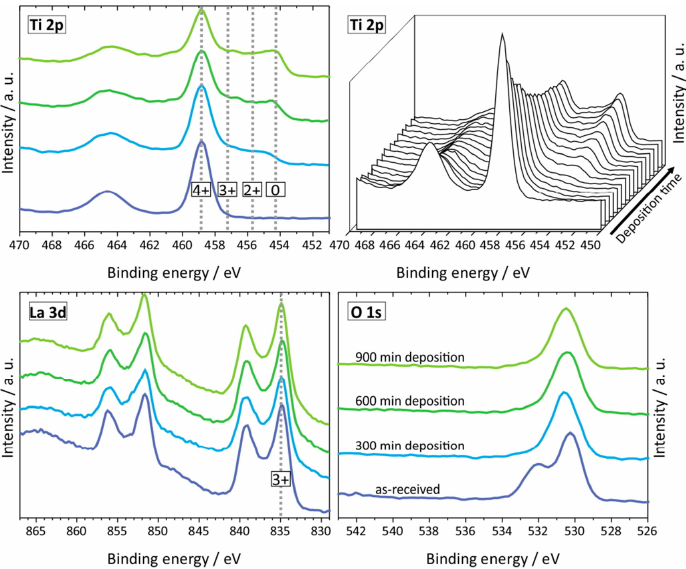
Figure 8. The Ti 2p, La 3d and O 1s detailed spectra for four different deposition times (different amounts of deposited Li metal). Reprinted from [84], Copyright (2015), with permission from Else- vier.